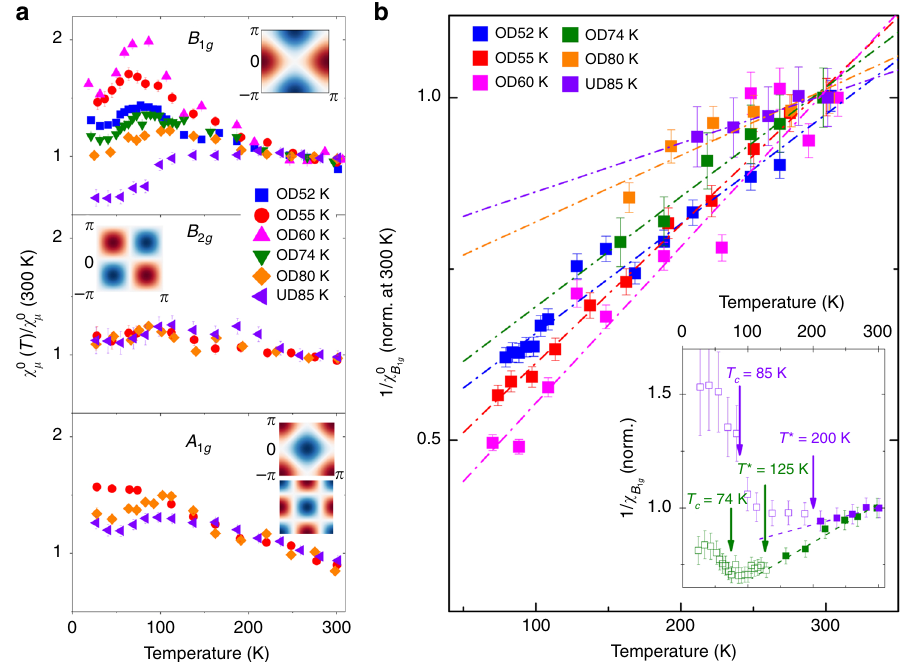
Fig. 2 Symmetry resolved static susceptibilities. a Temperature dependences of the static susceptibility in 3 different symmetries, B 1 g ; B 2 g , and A 1 g , as a function of doping. The form factors for each symmetry are depicted in reciprocal space in insets. They are given in terms of the lowest order Brillouin zone harmonics: cos( k ) − cos( k ) for B , sin( k )sin( k ) for B , cos( k ) + cos( k ) and cos( k )cos( k ) for A . The error bars correspond to the standard error of x y 1 g x y 2 g x y x y 1 g the low energy fi ts used for the low energy extrapolation (see supplementary note 1). b Curie-Weiss fi ts of the inverse B 1 g nematic susceptibility for temperatures above max( T T (cid:2) ). The inset shows the full temperature dependence of the inverse susceptibility of OD74 and UD85 where deviation from c Curie-Weiss law are observed at T (cid:2) , and an additional upturn is observed at T c . Full and open symbol correspond to data above and below T (cid:2) ,